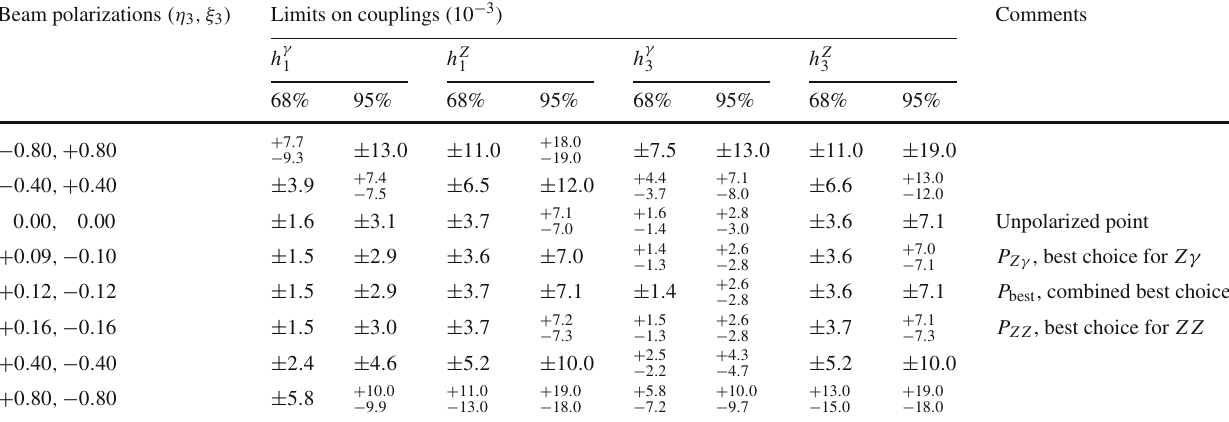
Table 2 List of simultaneous limits on anomalous couplings obtained for in Z γ process Beam polarizations (η 3 ,ξ 3